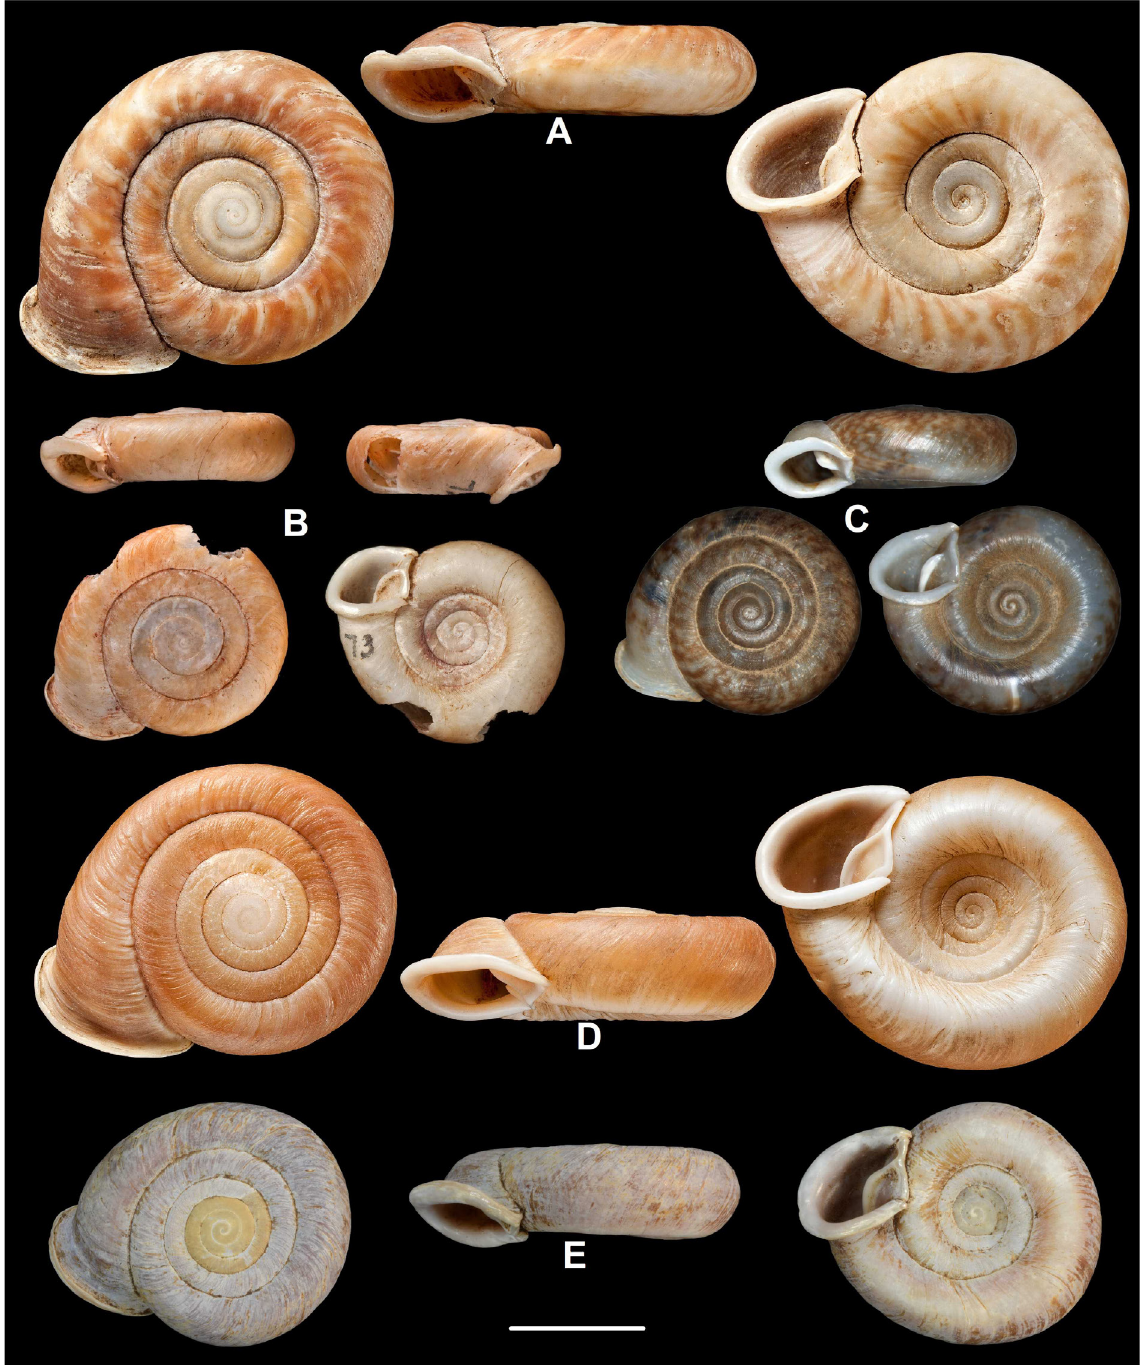
Fig. 34. Shells of species of Plectopylis Benson, 1860. A . P. anguina (Gould, 1847), paralectotype (NHMUK 20140812). B . P. cairnsi Gude, 1898, holotype (NHMUK 1922.8.29.47). C . P. cairnsi (UF 76761). D . P. bensoni Gude, 1914, paralectotype of Helix repercussa Gould, 1856 (NHMUK 20140813). E . Neotype of P. bensoni (NHMUK 20170143). Scale bar = 10 mm. Photos: T. Deli (C), B. Páll-Gergely (E) and H. Taylor (A–B,